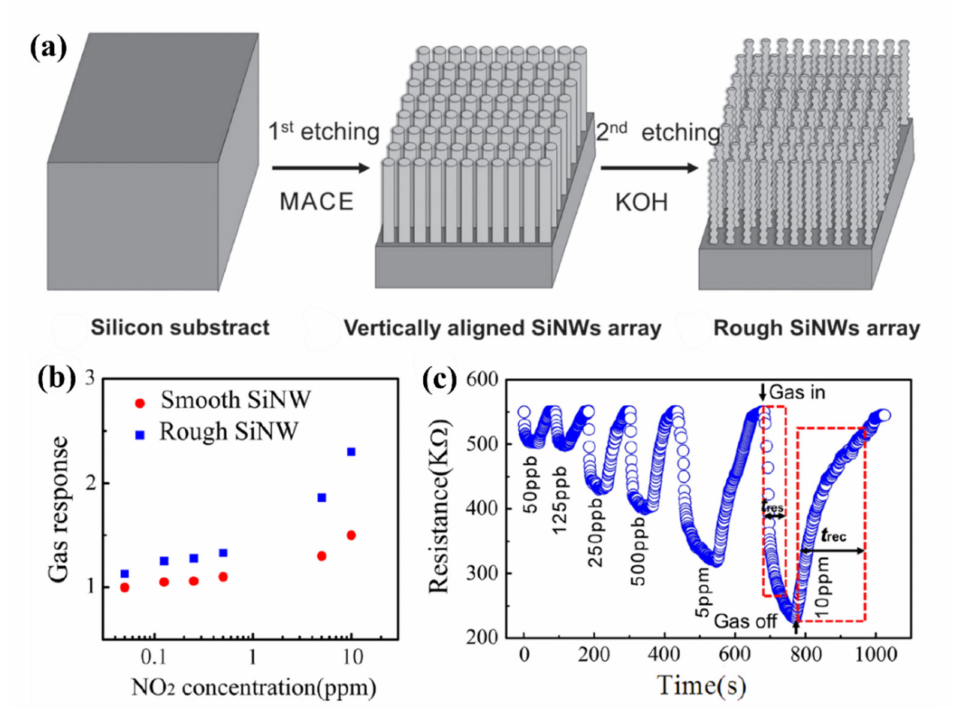
Figure 7. ( a ) Schematic illustration of the fabrication process for a rough SiNW array. ( b ) Sensor response as a function of NO 2 concentration at room temperature for normal smooth SiNWs and rough SiNWs. ( c ) Dynamic response curve of the rough SiNWs array sensor to varying concentrations of NO 2 . Reproduced from [133], with permission from Springer Nature,